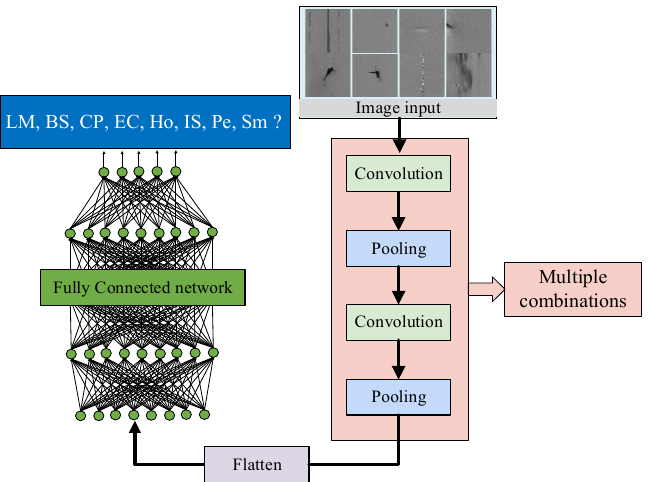
Figure 5. General structure of the surface defect CNN model.